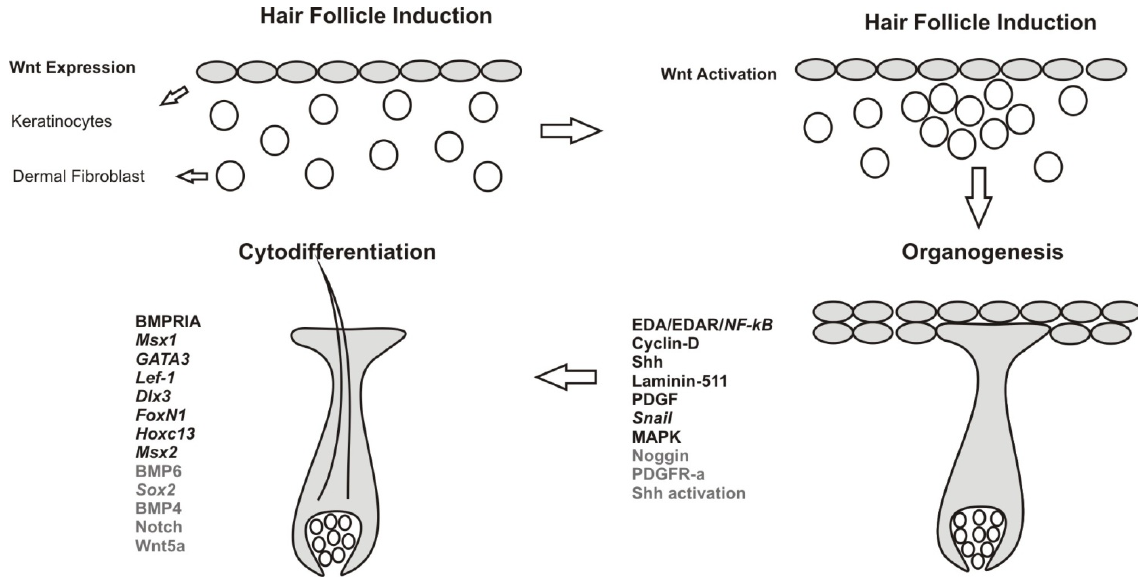
Figure 2. Stages of hair follicle morphogenesis. HFs are formed by interaction between epithelium (keratinocytes) and underlying dermal fibroblasts. Comprehensive lists of signaling molecules (capitals) and transcription factors (italics) are provided for each stage. Signaling molecules and pathways indicated in black are either expressed or activated in keratinocytes while grey ones are associated with dermal